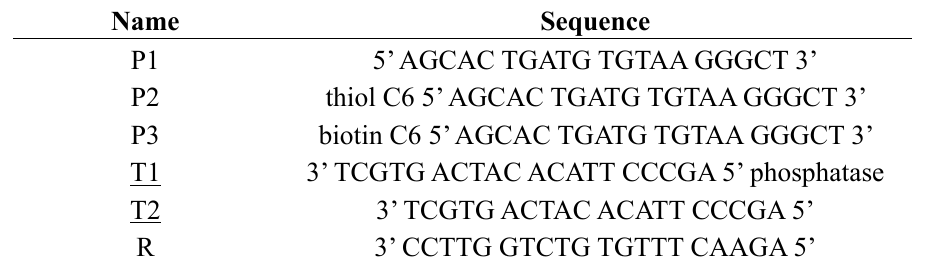
Table 1. DNA probes (P), complementary targets (T) and random strand (R)